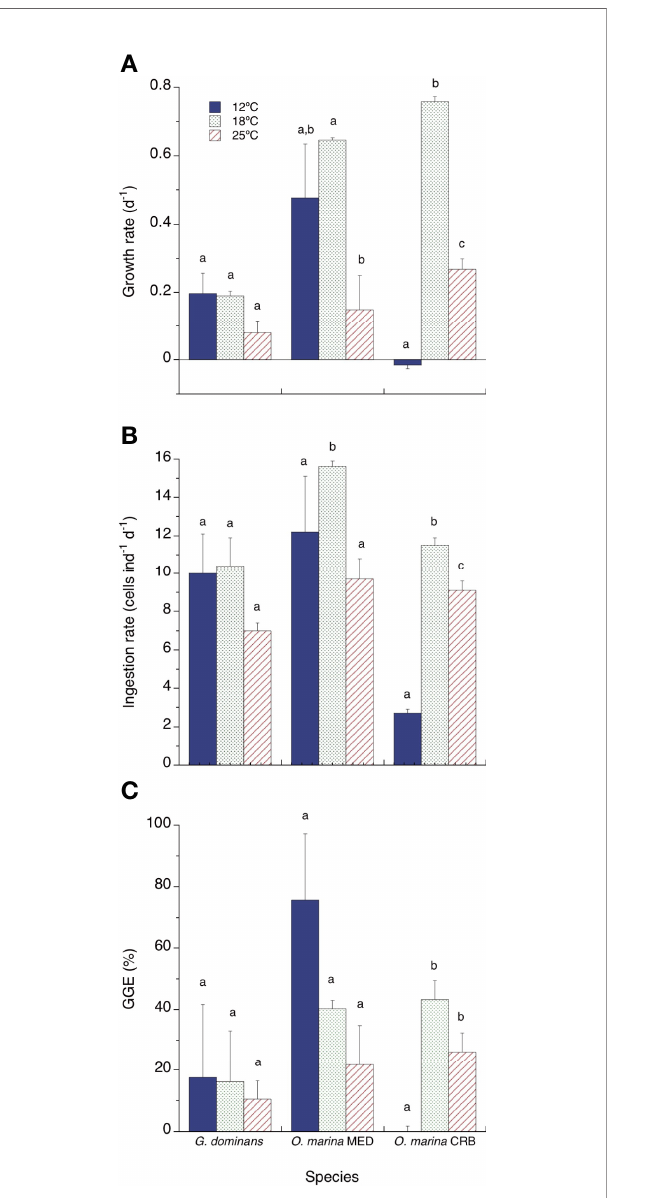
FIGURE 2 | Respiration rates (µmol O 2 ind -1 d -1 ) of starved and fed (A) G dominans , (B) O. marina MED, and (C) O. marina CRB at the different temperatures investigated. Statistical differences (p<0.05) within each species are indicated by different letters. The error bars are